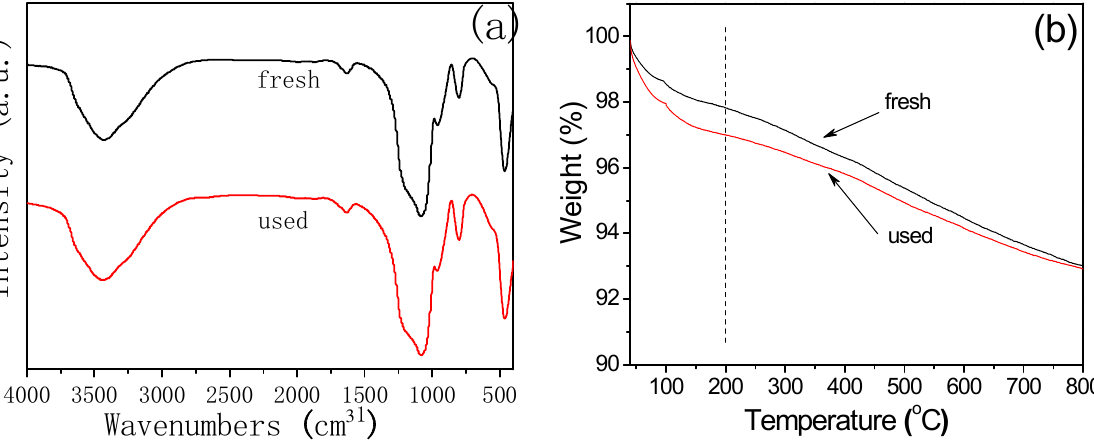
Figure 9. ( a ) FT-IR spectra of fresh and used 10 wt% NiO/KIT-6 catalysts and ( b ) TG curves of fresh and used 10% NiO/KIT-6 catalysts.